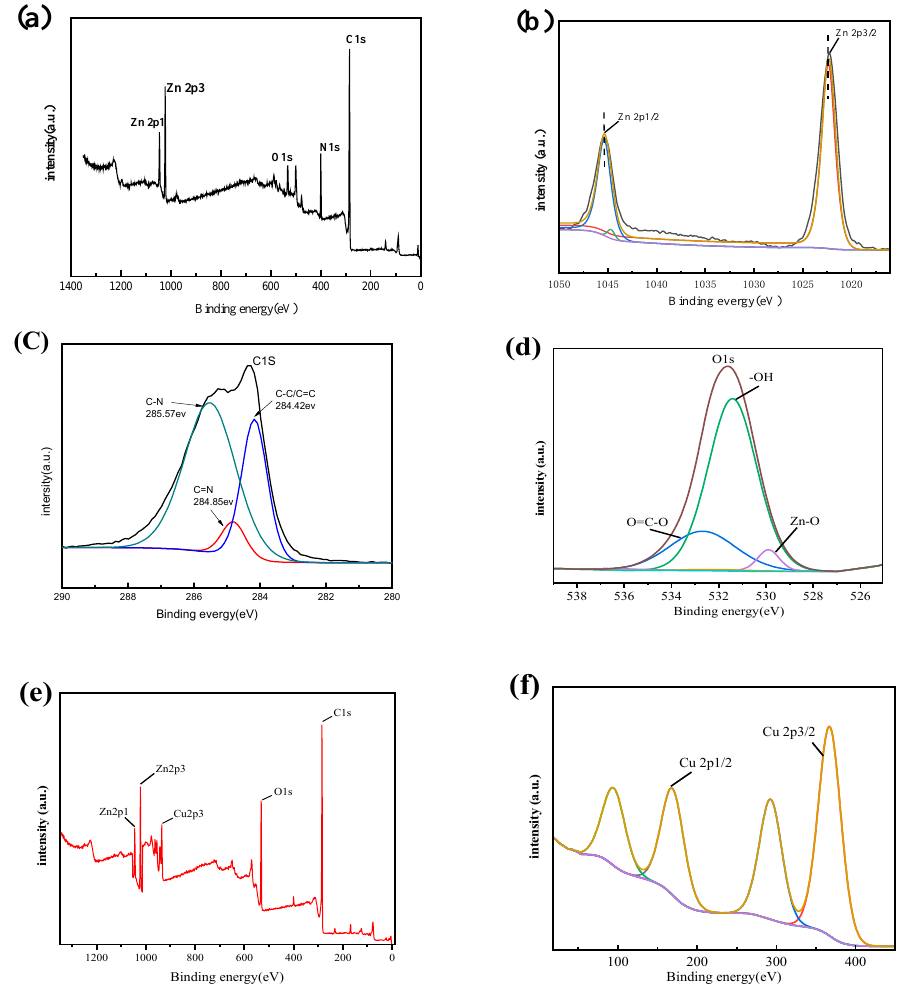
Figure 7. XPS analysis of: ( a ) survey scan of MGO@ZIF-8, ( b ) Zn 2p, ( c ) C 1s, ( d ) O1s,( e ) survey scan of Cu-MGO@ZIF-8, and ( f ) Cu 2p.